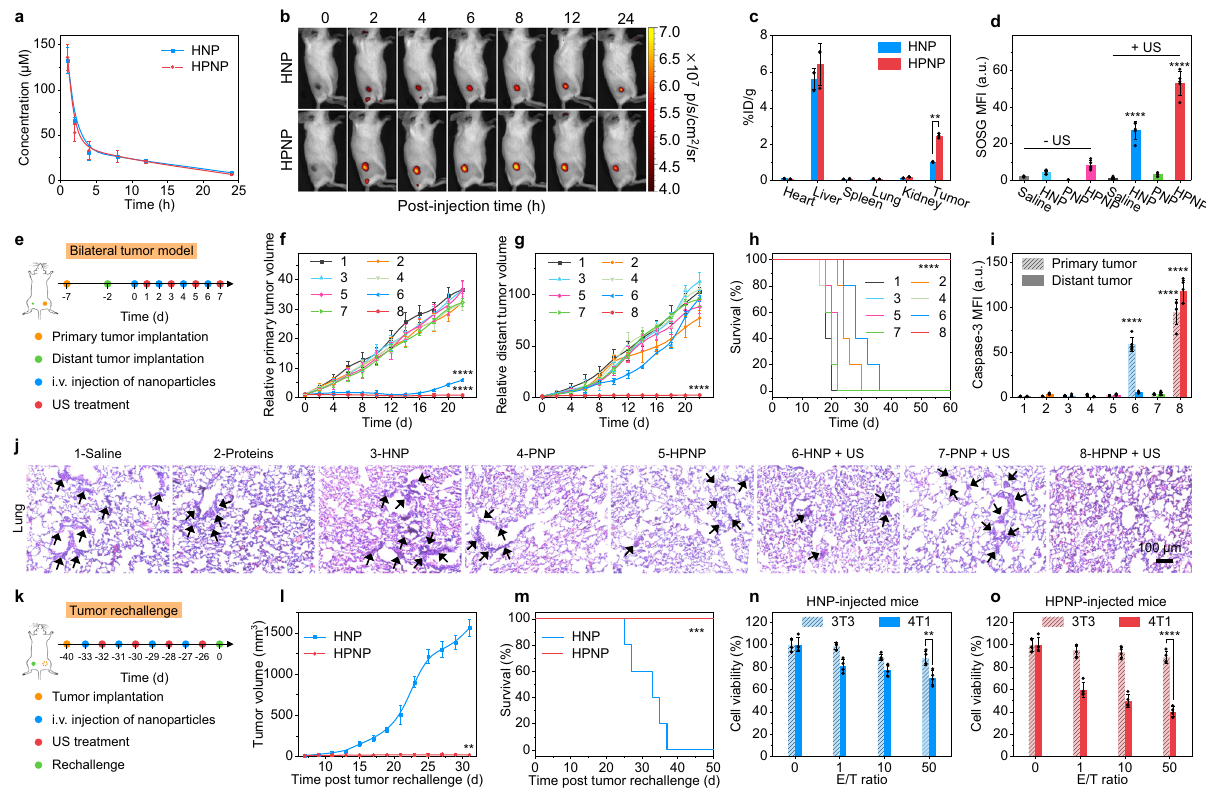
Fig. 4 In vivo NIR fl uorescence imaging and nano-immunocomplex-mediated activatable sono-metabolic checkpoint trimodal cancer therapy. a Pharmacokinetic analysis of blood concentration of HP in BALB/c mice at t = 1, 2, 4, 8, 12, or 24 h post-injection of HNP or HPNP ( n = 3). b NIR fl uorescence imaging of 4T1 tumor-bearing BALB/c mice at t = 0, 2, 4, 6, 8, 12, or 24 h post-injection of HNP or HPNP (injection dose: 200 μ L, [HP] = 1 mmol/L, or [ADA] = 40 U/mL). c Biodistribution of HNP or HPNP in 4T1 tumor-bearing mice at 24 h after systemic administration ( n = 3). HPNP versus HNP in tumors: p = 0.0035. d Quantitative analysis of SOSG MFIs in tumor tissues from HNP-, PNP-, or HPNP-injected mice with or without sono- irradiation (1.0 MHz, 1.2 W/cm 2 , 50% duty cycle) for 6 min ( n = 5). HNP + US versus HNP: p < 0.0001; HPNP + US versus HPNP: p < 0.0001. e Schematic illustration of the schedule for bilateral tumor model implantation and nano-immunocomplex-mediated activatable sono-metabolic checkpoint trimodal cancer therapy. Growth curves of primary tumors ( f ) and distant tumors ( g ) after different treatments ( n = 5). 6 versus 1 in f : p < 0.0001; 8 versus 1 in f : p < 0.0001; 8 versus 1 in g : p < 0.0001. h Survival curves for the mice after different treatments using the Kaplan – Meier method ( n = 5). p <